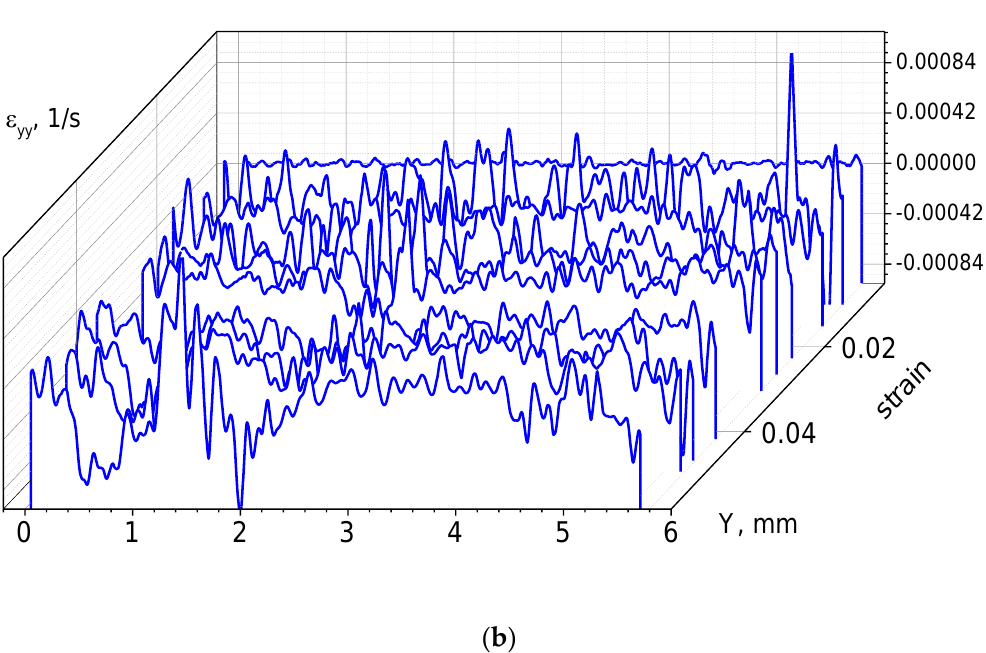
Figure 19. Evolution of ROST components X = ( b ) . Data from Sample #4 are shown.